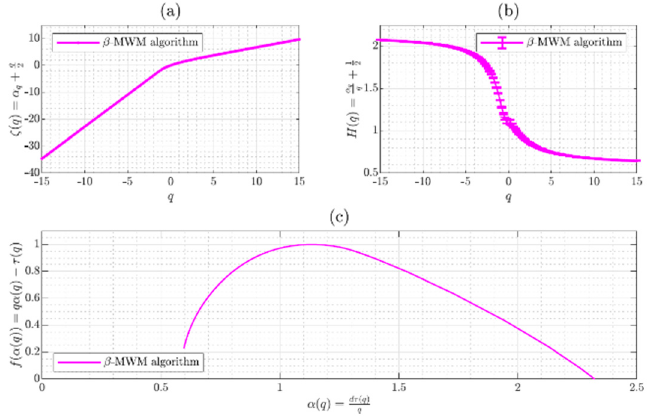
Figure 9. ( a ) Multiscale diagram (MD) for the trace synthesized by the β -MWM algorithm; ( b ) linear multiscale diagram (LMD) for the trace synthesized by the β -MWM algorithm; ( c ) multifractal spectrum (MS) for the trace synthesized by the β -MWM algorithm.